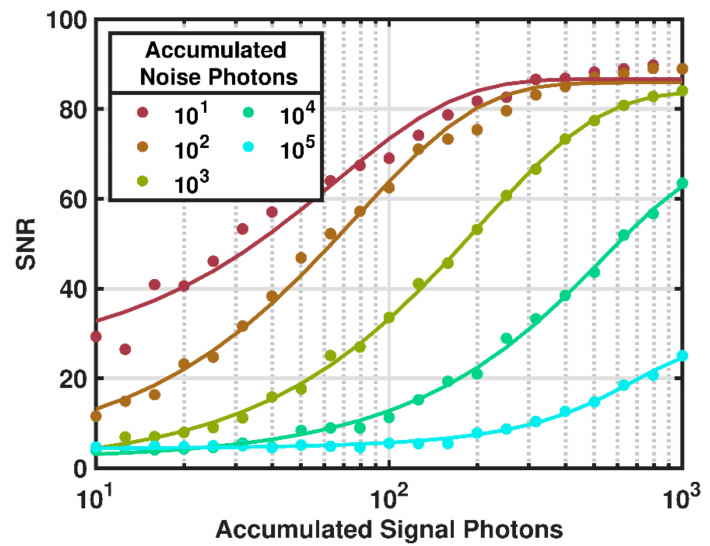
Figure 8. Plot of SNR as a function of accumulated signal photons under various noise photon accumulation levels. The SNR is calculated as described in Section 2.1. An SNR < 6 corresponds to a probability of detection of <~80%. Each point corresponds to the average of five independent simulations. The lines denote best fit error functions for each accumulated noise